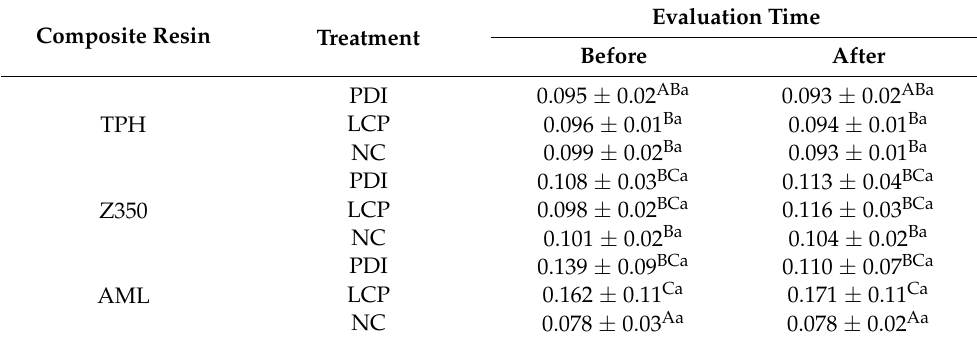
Table 4. Mean values ( ± standard deviation) of roughness values (in µ m) obtained before treatment and after treatment (PDI: photodynamic therapy; LCP: Liquid crystal precursor without curcumin; NC: negative control/artificial saliva) and organized by composite resin (TPH, Z350, and AML). Evaluation Time Composite Resin Treatment Before